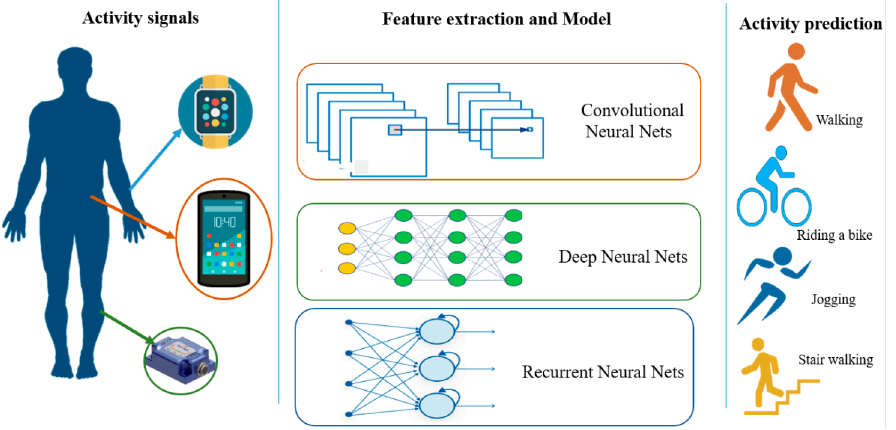
Figure 2. Deep learning for a sensor-based